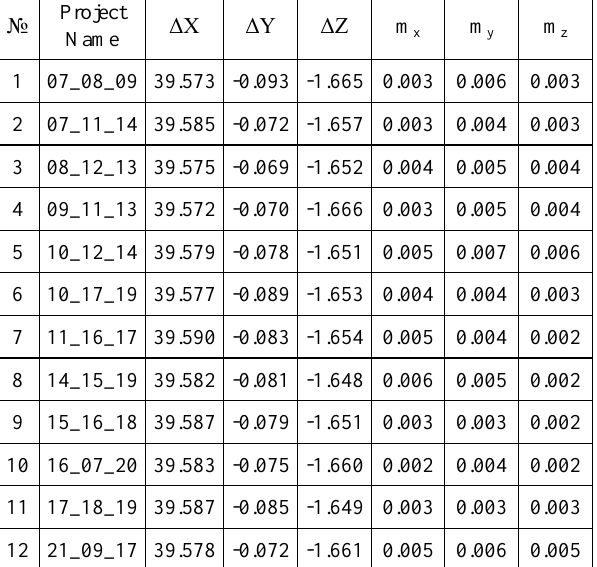
Table 3. Computed relative positions of the blocks of marks and their standard